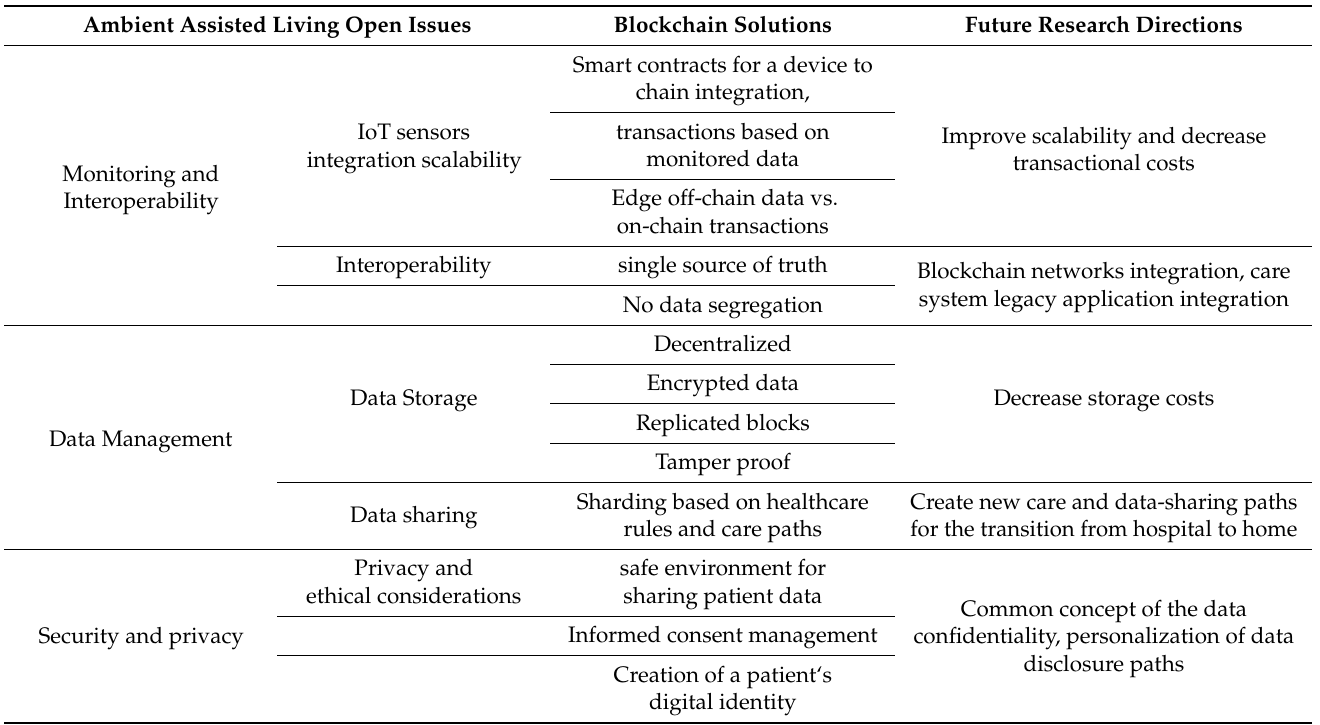
Table 6. Assisted living issues and blockchain